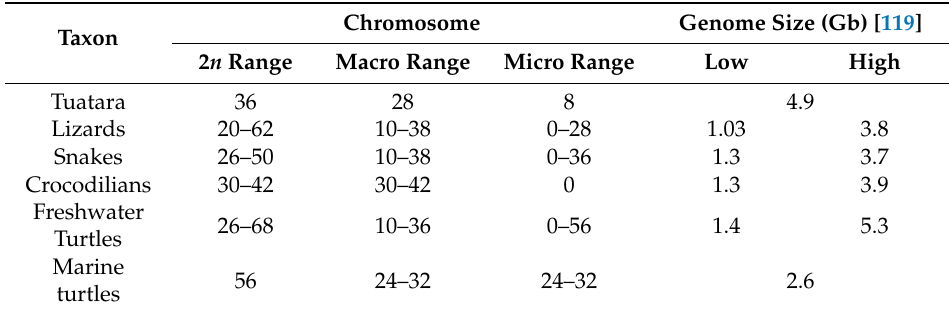
Table 1. Ranges of diploid chromosomes numbers and numbers of macro and microchromosomes and genome sizes in major groups of